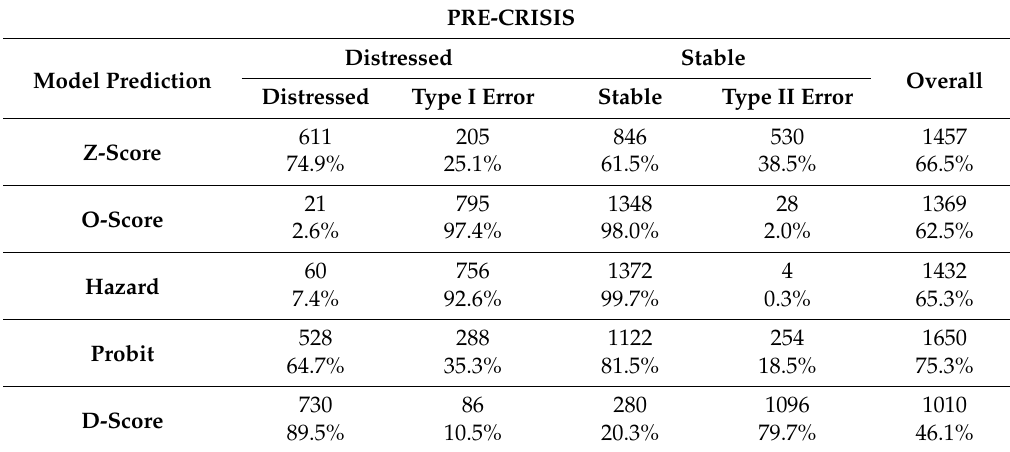
Table 6. Prediction accuracy of models before financial